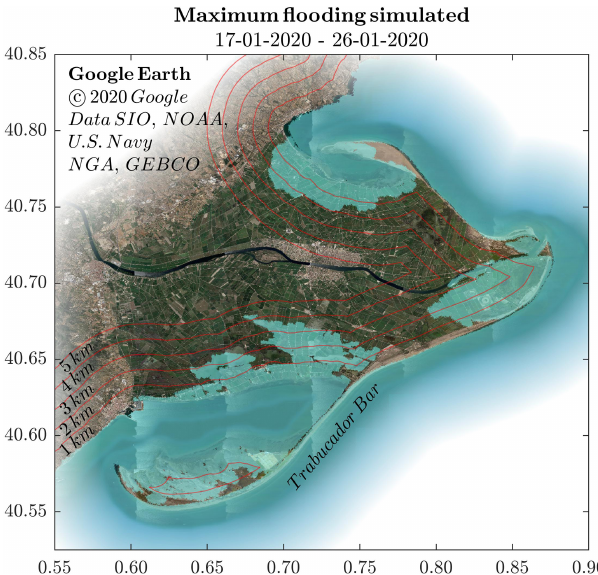
Figure 7. Simulated flooded area in the Ebro Delta caused by the storm surge. Red lines indicate distance from coast.